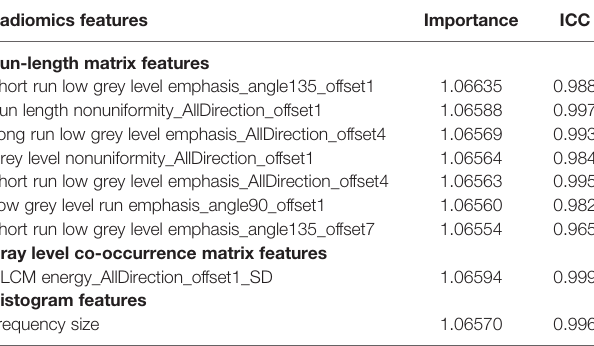
TABLE 3 | Names, categories, importance, and ICC of the selected radiomics features. Radiomics features